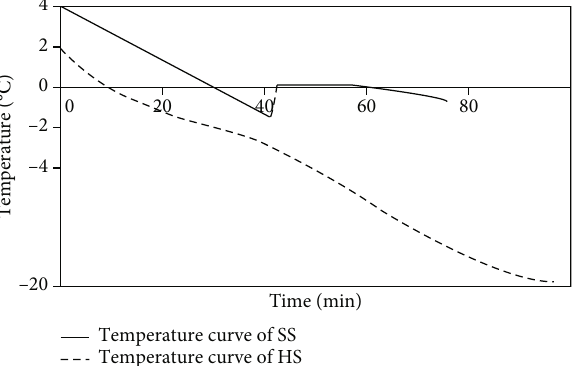
Figure 5: Cooling curves of specimens in SS and